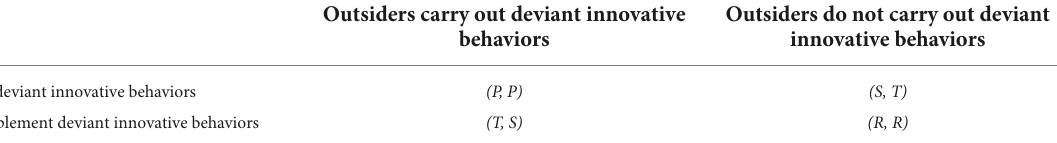
TABLE 1 Game matrix of real